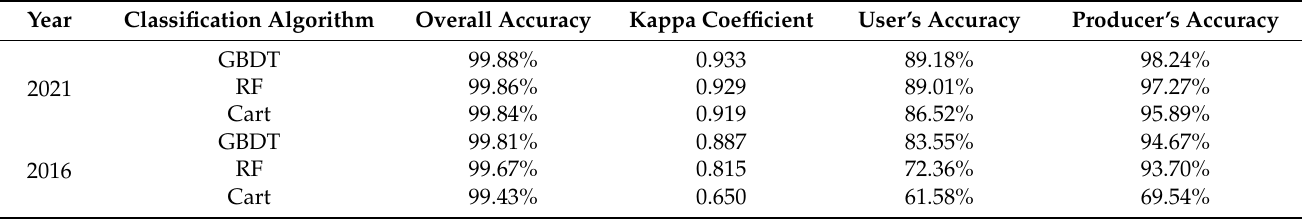
Table 5. The accuracy of comparisons between the extraction results of lakes on the Tibetan Plateau and verified datasets.